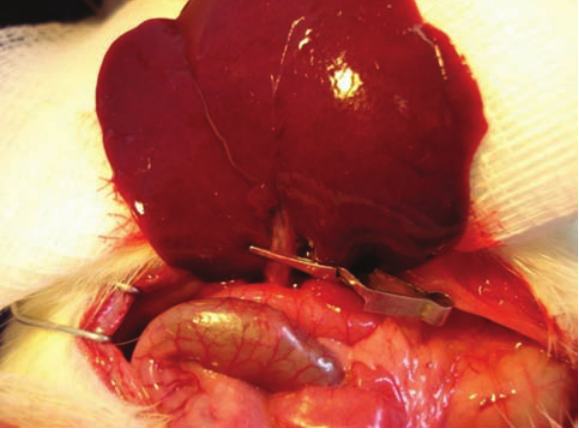
Figure 1 - Structures in the portal triad (hepatic artery, portal vein, and bile duct) in the median and left lateral hepatic lobes (70% of the liver) clamped with an atraumatic, microvascular